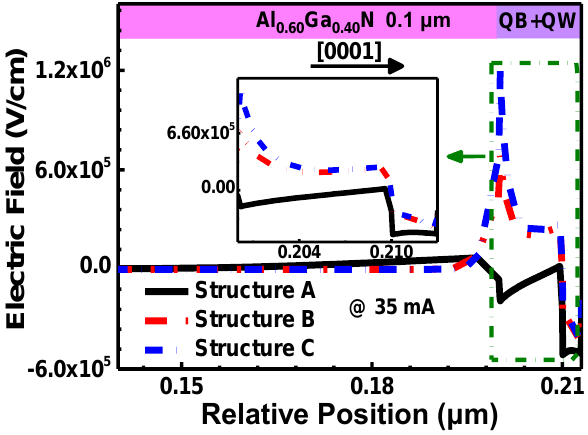
Figure 4. Electric field profiles in the n-Al 0.60 Ga 0.40 N layer and the first QB/QW for Structures A, B, and C, respectively, at the injection current of 35 mA.